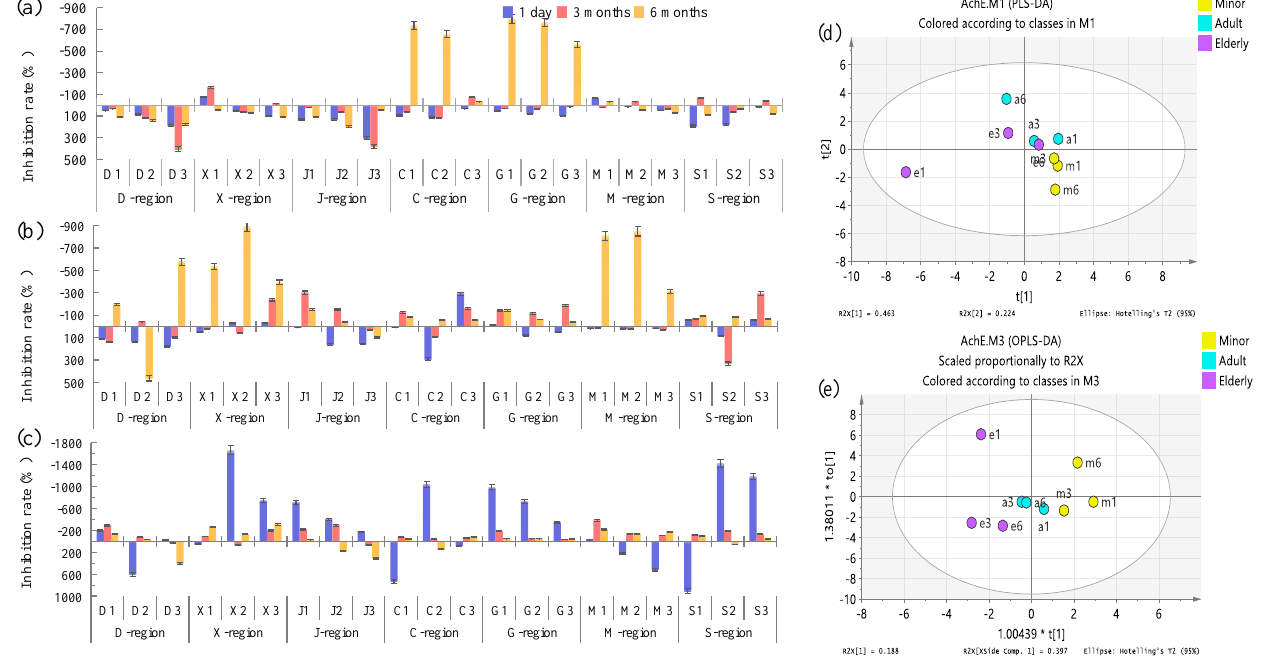
Figure 8. Inhibition rate of COF condensates on AchE of minors ( a ), adults ( b ), and the elderly ( c ) and their PLS-DA ( d ) and OP LS-DA ( e ) diagrams.